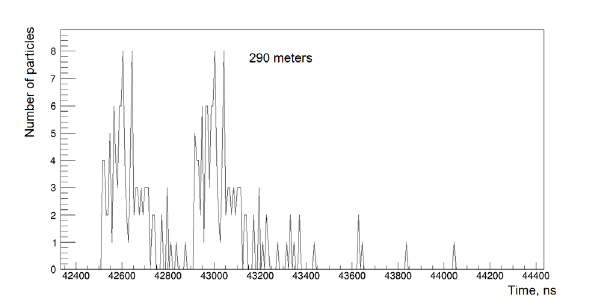
Figure 12. Two EAS disks with 100ns delay, detector is 290 m from axis.